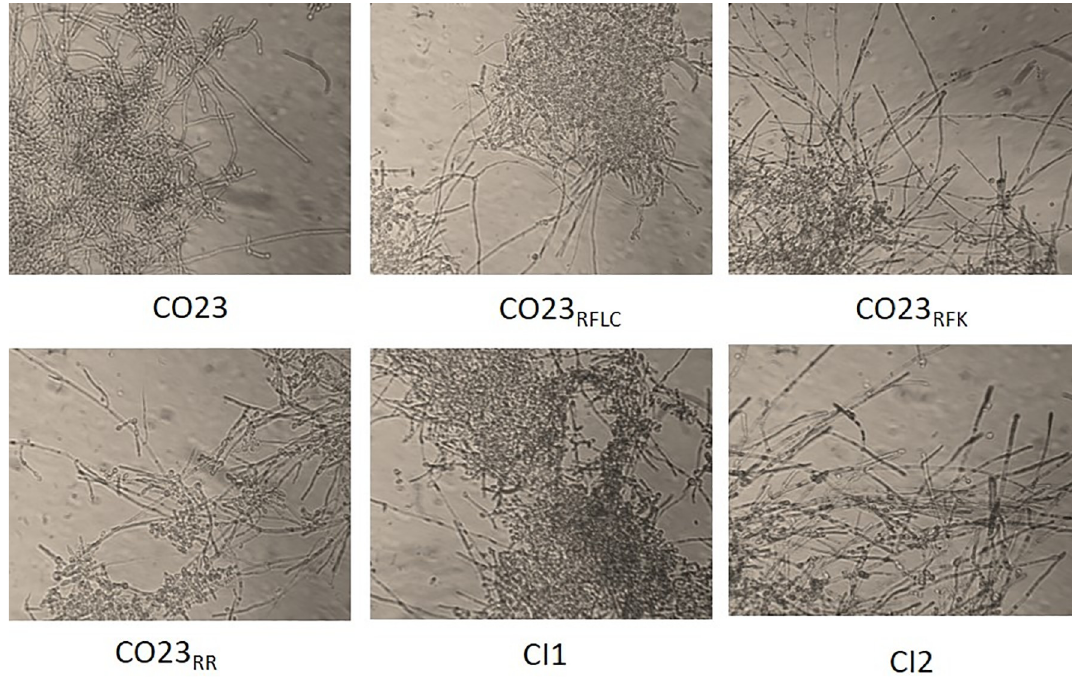
Fig 5. Filamentation in C . albicans . Hyphal growth of C . albicans strains CO23 S , CO23 RFK , CO23 RFLC , CO23 RR , CI1 and CI2. Cells were induced to form hyphae by 24 h incubation at 37˚C in RPMI 1640 medium containing 10% fetal calf medium. Photomicrographs were taken by a phase contrast microscope using a 40x objective and they are representative of 50% random fields observed.